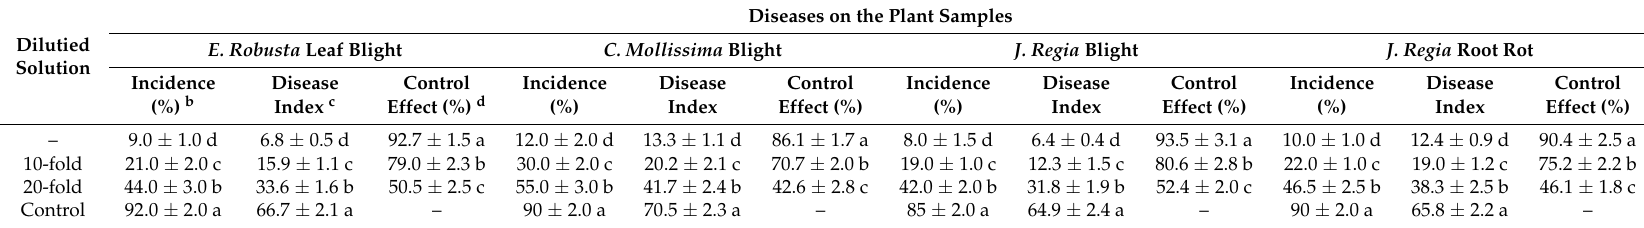
Table 2. Biological control effect of the recombinant chitinase against Eucalyptus robusta Smith leaf blight, Castanea mollissima BL. blight, Juglans regia L. blight and J. regia root rot in pot experiment a